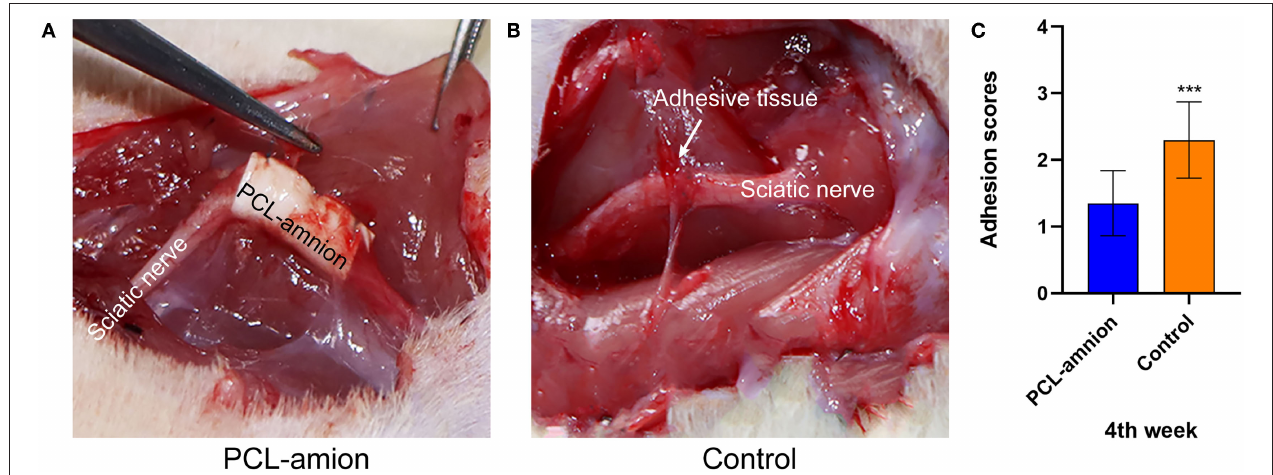
FIGURE 1 | Adhesion assessment of the two groups at four weeks. (A) The PCL-amnion nanofibrous membrane group. (B) The Control group. (C) Adhesion scores of each group at each time point ( P < 0.05). *** P < 0.001 compared to the PCL-amnion